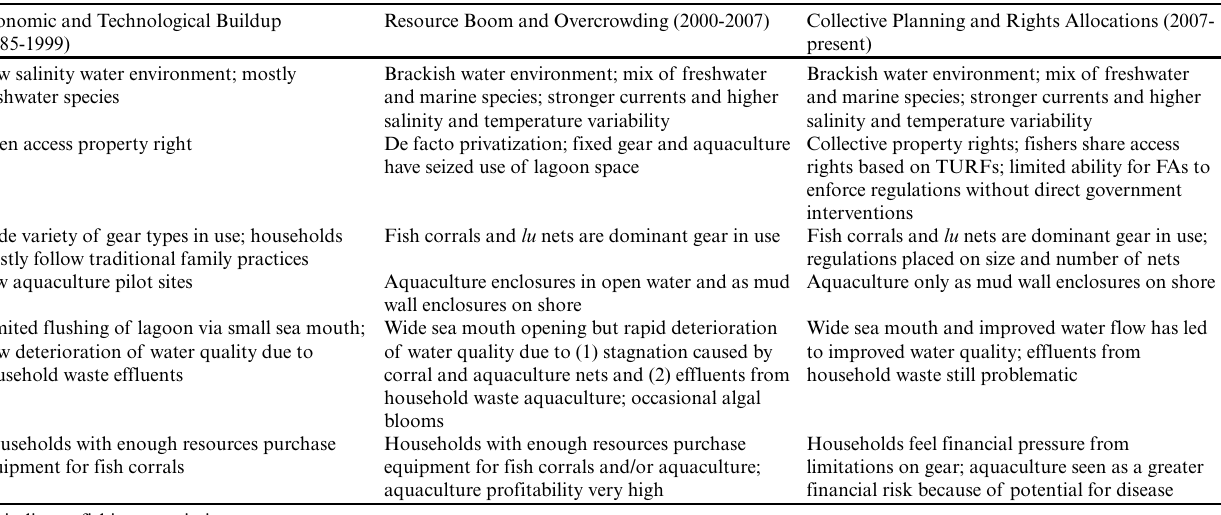
Table 5 . Differences between social-ecological system (SES) identities with respect to fishers’ livelihoods and well-being. The collective planning phase shows some potential for a third system identity, but territorial user rights for fishers (TURFs) and comanagement have yet to fully stabilize SES